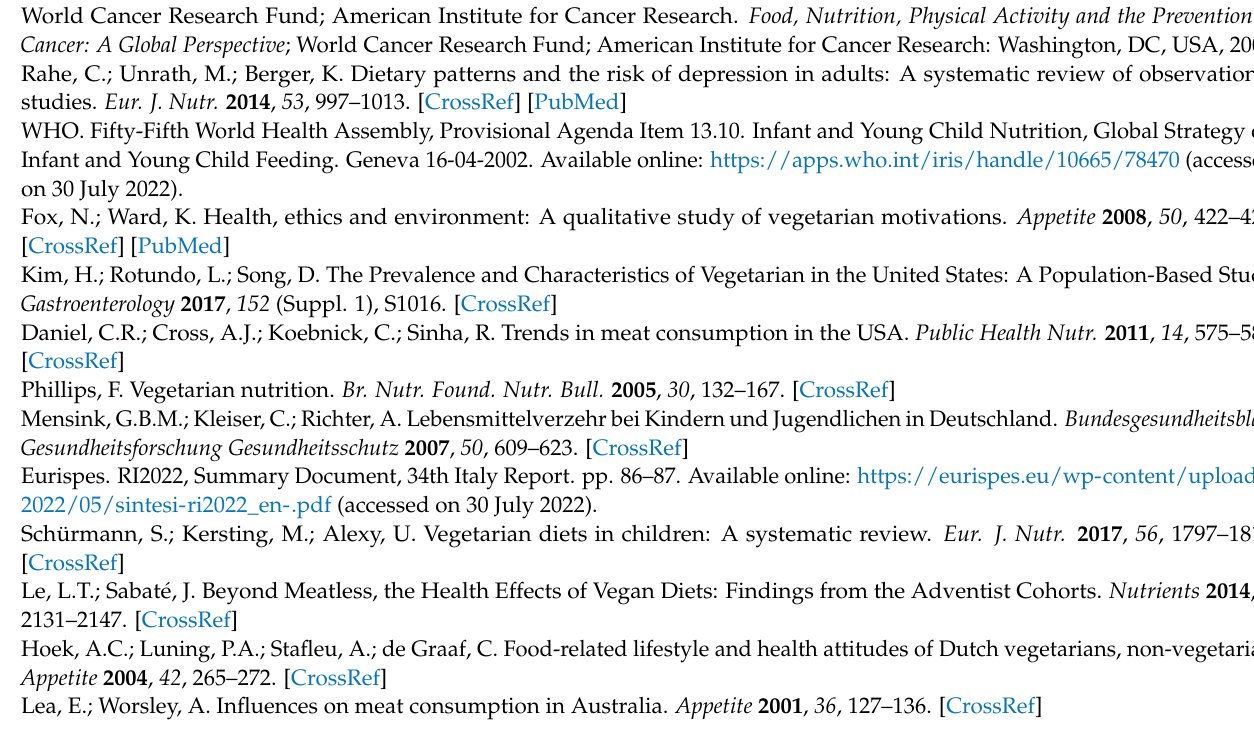
Characteristics and Results; Table S3d: Included Guidelines and other Documents: Recommendations and Grading; Table S3e: Included studies. Characteristics and Results; Table S3f: Included Case reports. Characteristics and Results; Table S3g: Included studies. Characteristics and Results; Table S3h: Included Guidelines and other Documents: Recommendations and Grading; Table S3i: Included studies. Characteristics and Results.) File S4: Additional analysis of the results. File S5: Summary of findings for the main comparisons. (Table S5a: Vegetarian diet during the complementary feeding period. Different auxological development and/or growth; Table S5b: Vegetarian diet during the complementary feeding period. Psychomotor development; Table S5c: Vegetarian diet during the complementary feeding period. Risk of developing Obesity/Overweight; Table S5d: